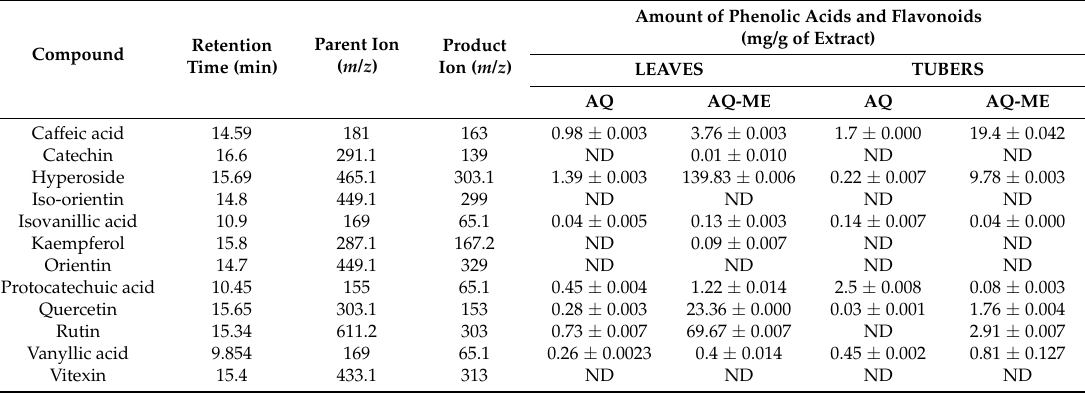
Table 1. Quantification of phenolic acids and flavonoids in aqueous and aqueous-methanol extracts of orange fleshed sweet